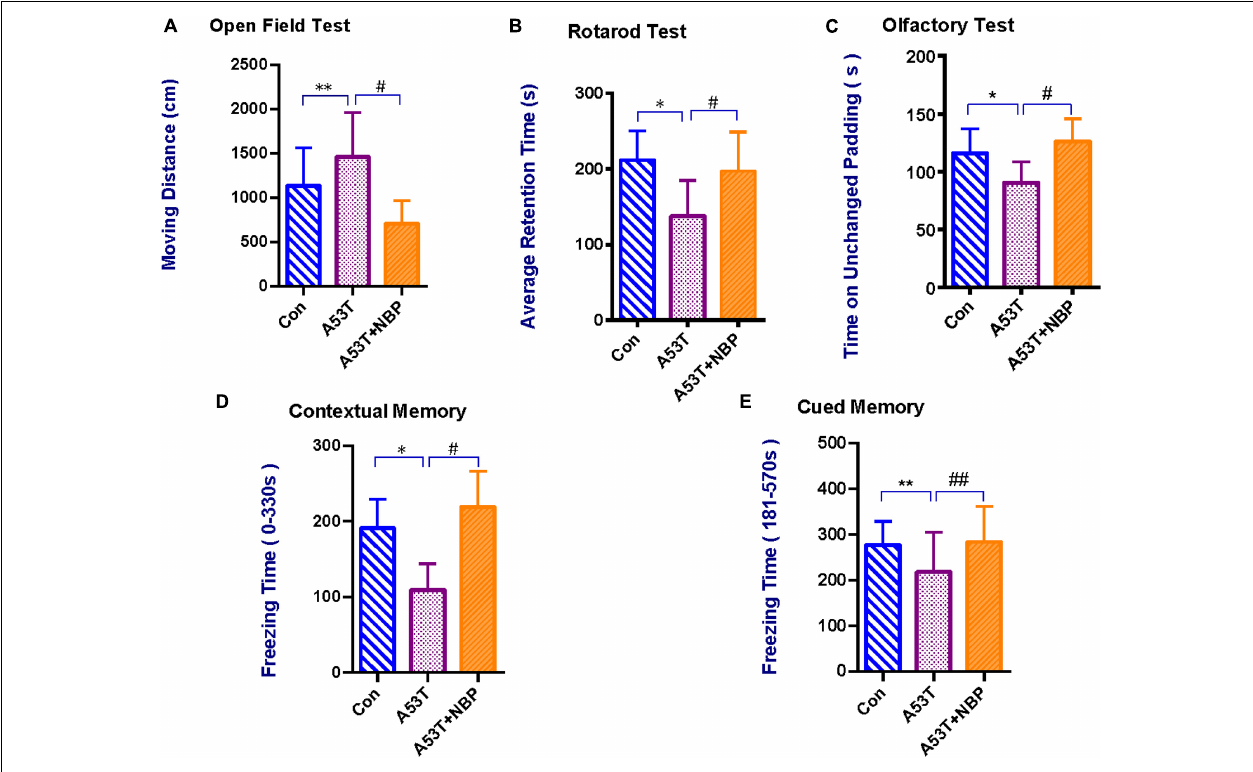
FIGURE 1 | Behavioral and cognitive assessments. Compared with the control group, the A53T group exhibited a significant longer moving distance in the Open Field Test (A) , significant reductions in average retention time in the Rotarod Test (B) , time on unchanged padding in the Olfactory Test (C) , and freezing time during contextual memory and cued memory tests in Contextual Fear Conditioning (D,E) (** P < 0.01; * P < 0.05). After 2-week Dl-3-n-butylphthalide (NBP) treatment, the results were significantly reverted ( # P < 0.05; ## P < 0.01). All data were expressed as mean ±